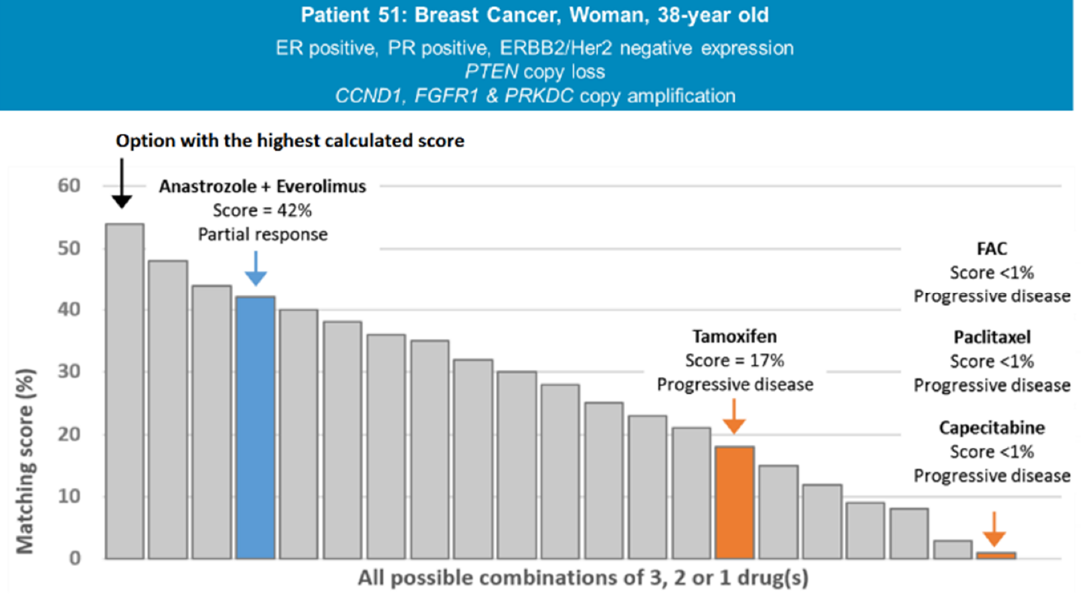
Figure 3. Comprehensive analysis of treatment regimens received by Patient 51. Abbreviations: CCND1 = cyclin D1; ER = estrogen receptor; ERBB2 / Her2 = erb-B2 receptor tyrosine kinase 2; FAC = fluorouracil, doxorubicin, cyclophosphamide; FDA = Food and Drug Administration; FGFR1 = fibroblast growth factor receptor 1; PR = progesterone receptor; PRKDC = protein kinase, DNA-activated, catalytic polypeptide; PTEN = phosphatase and TENsin homolog.